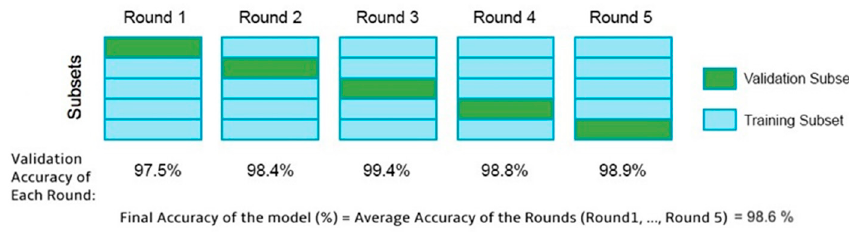
Figure 12. Validation accuracy of 5-fold cross validation.